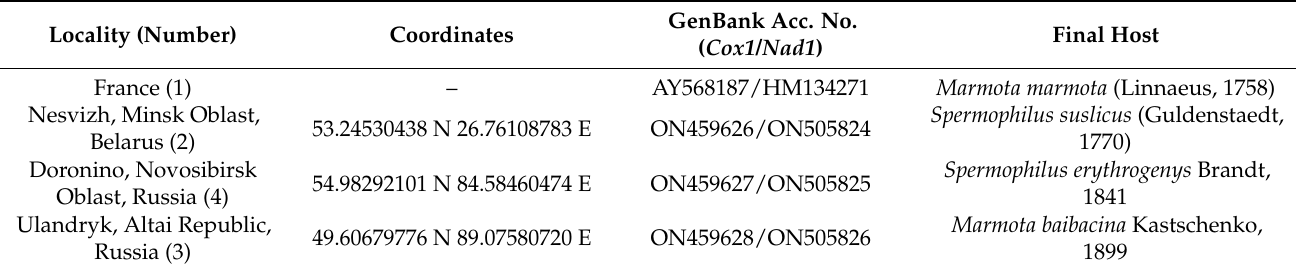
Table 1. List of examined specimens of Ctenotaenia marmotae and GenBank accession numbers according to geographical origin. Specimens, except for AY568187 and HM134271, were collected and sequenced by the authors.